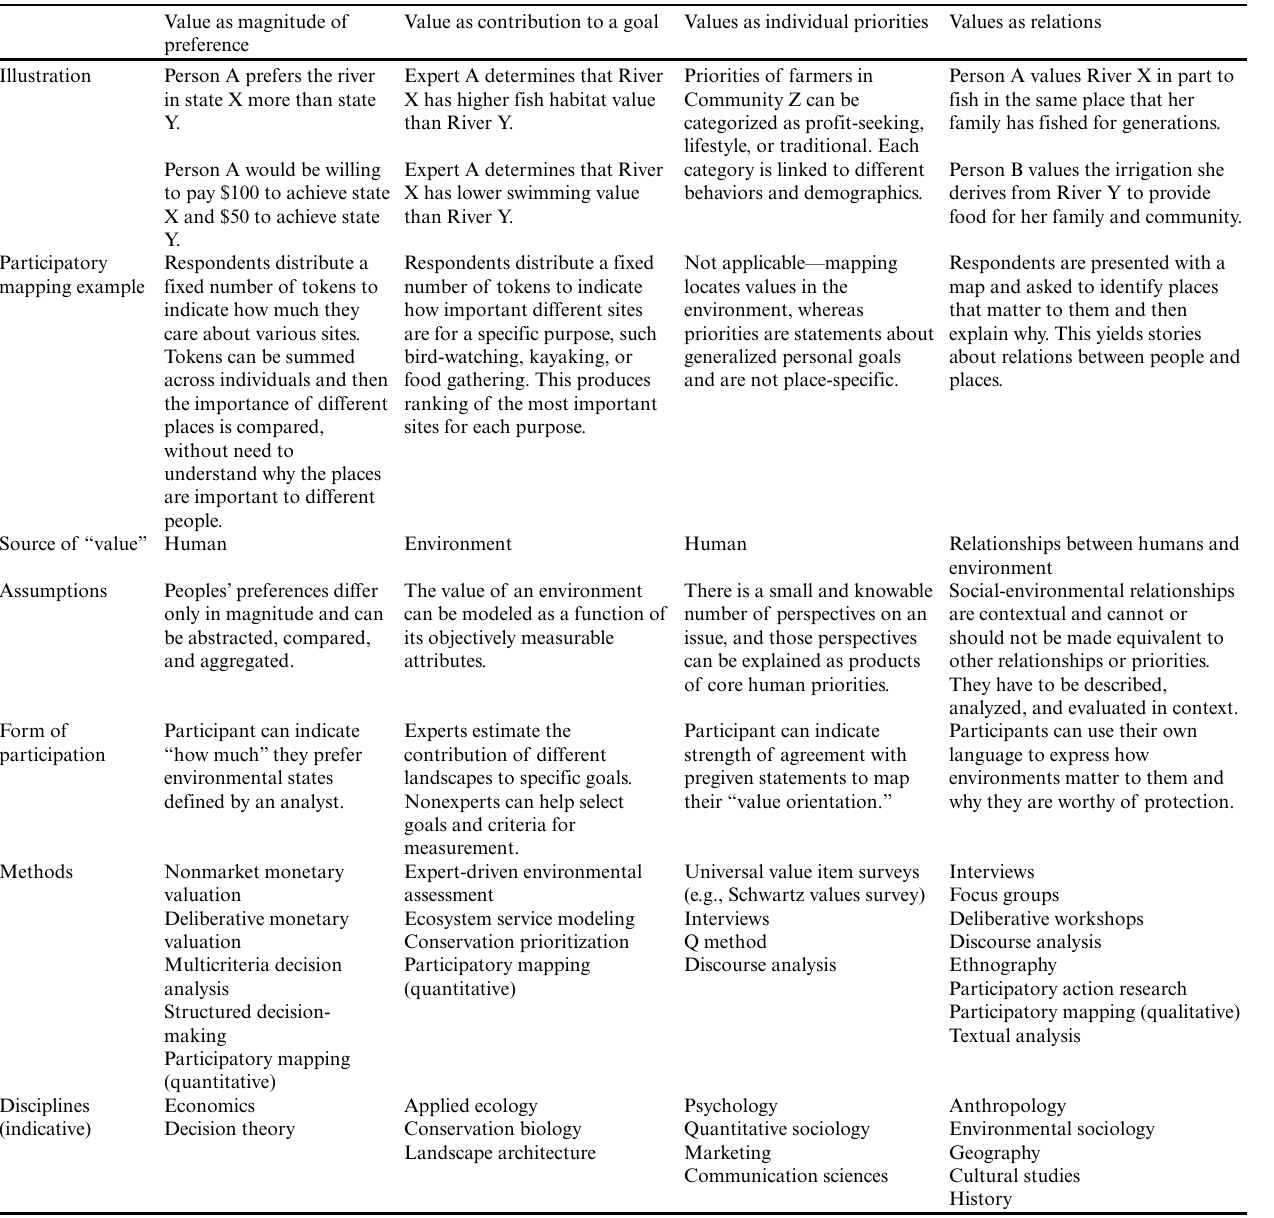
Table 1 . Key features and forms of participation for four concepts of value, with commonly associated methods and disciplines. Value as magnitude of preference